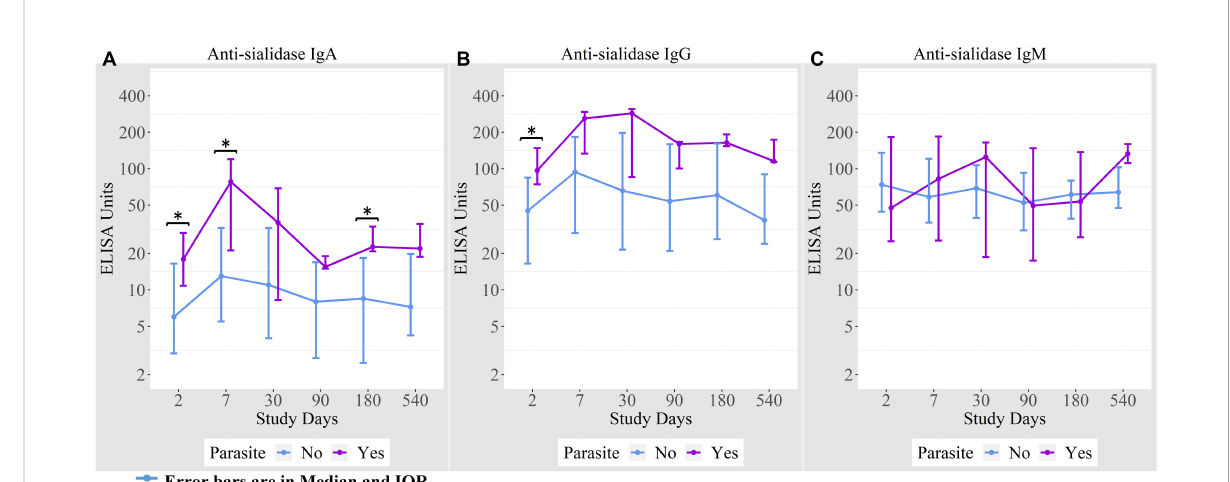
FIGURE 5 (A) Anti-sialidase IgA responses among patients with and without intestinal parasite co-infection (B) Anti-sialidase IgG responses among patients with and without intestinal parasite co-infection (C) Anti-sialidase IgM responses among patients with and without intestinal parasite co-